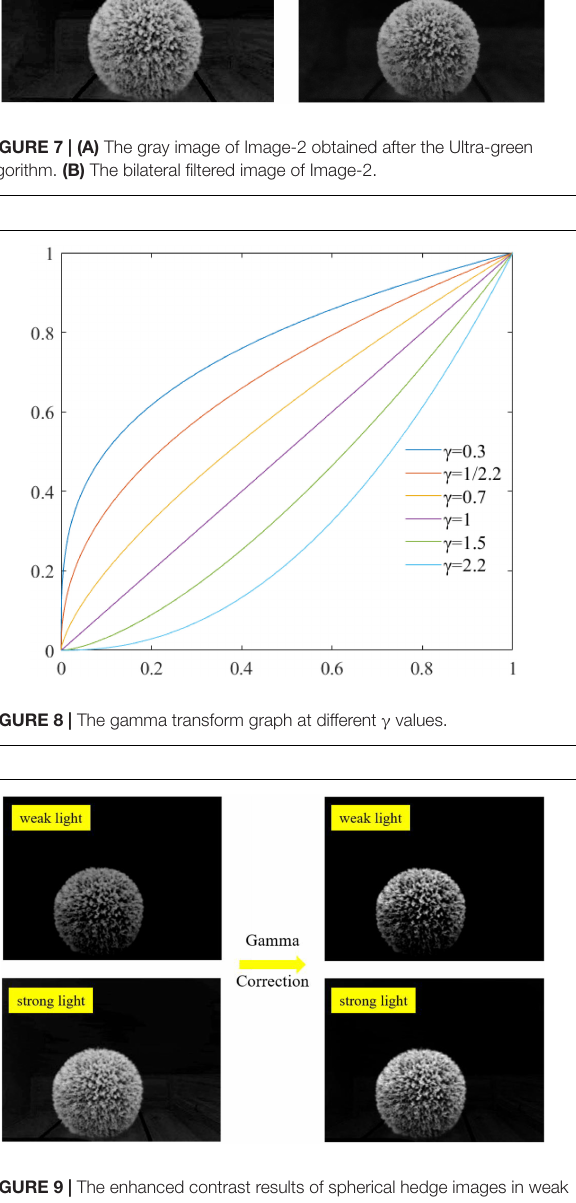
FIGURE 9 | The enhanced contrast results of spherical hedge images in weak light and strong light.